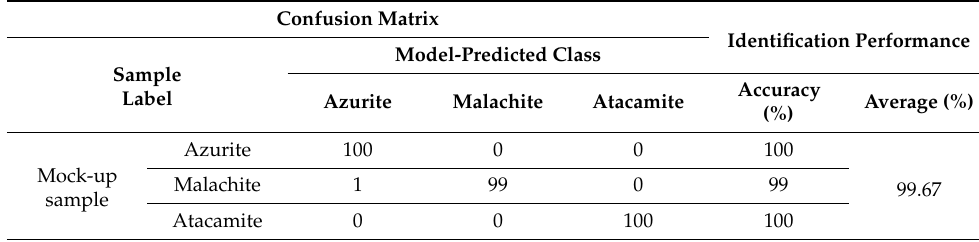
Table 4. Confusion matrix and accuracy of Bp-ANN identification model for three